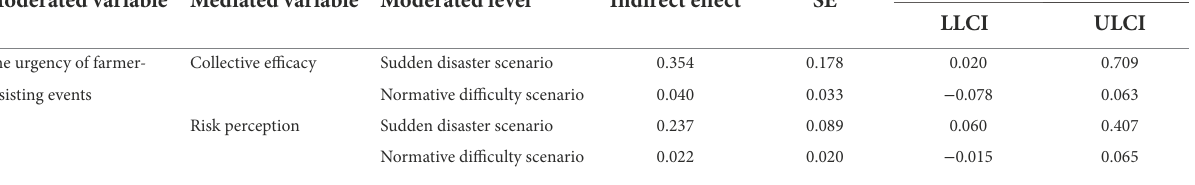
TABLE 7 Test results of the moderated mediating effects based on